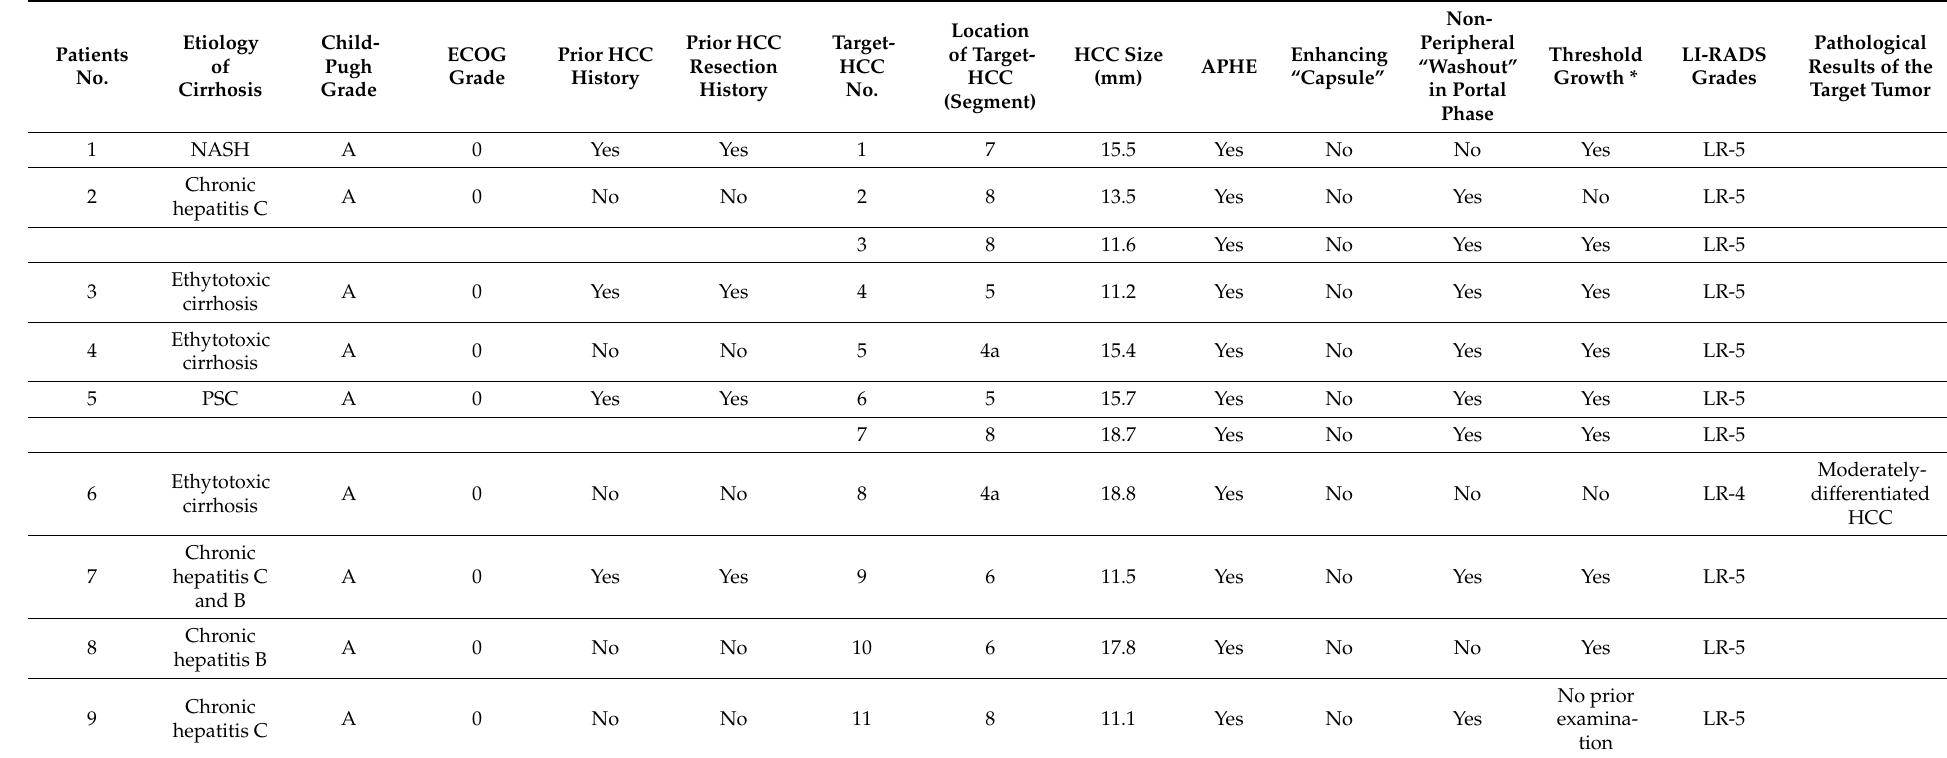
Table 1. Patient collective and target-HCC